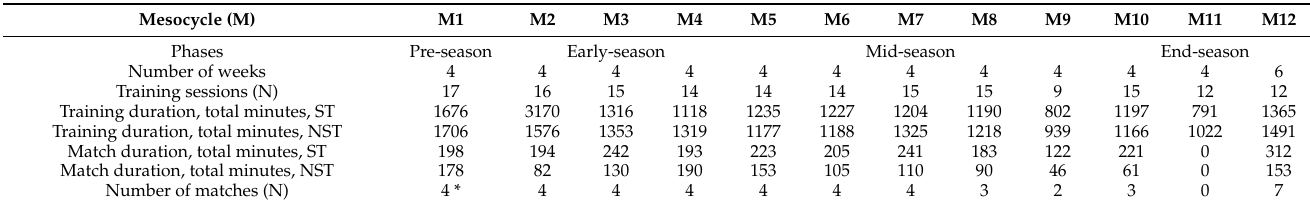
Table 1. Description of macrocycle of the present